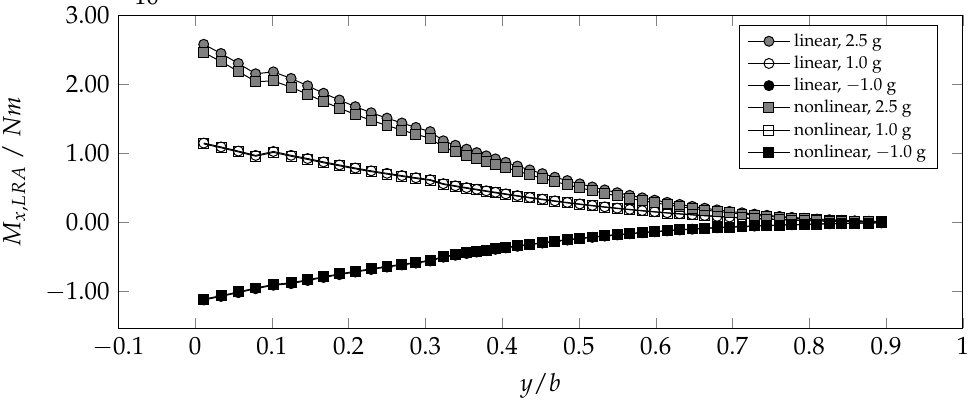
Figure 6. Bending moment over spanwise position normalised by reference half span, loads reference axis coordinate system for a transport aircraft wing.